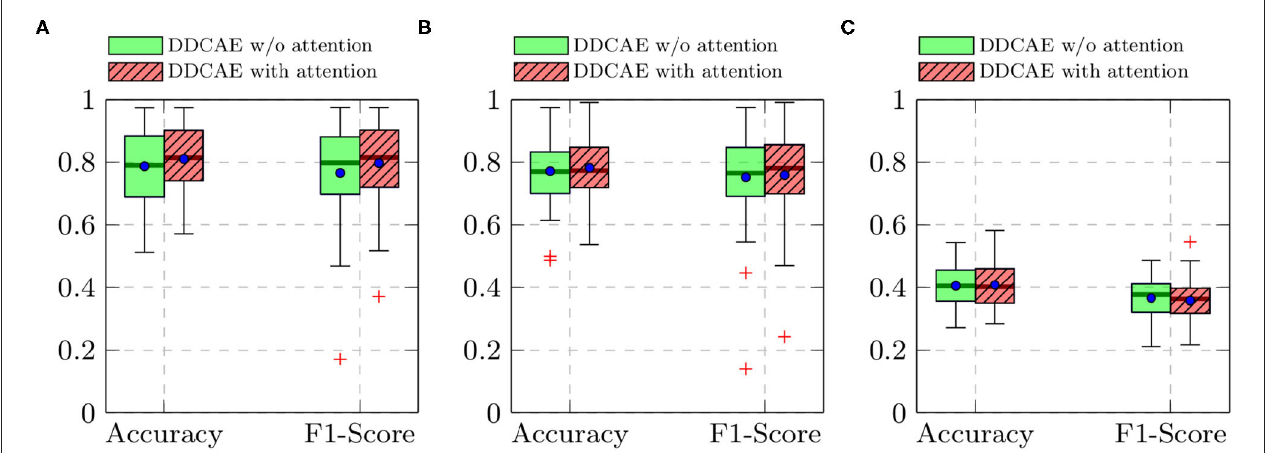
FIGURE 8 | SenseEmotion Database: classification performance comparison in a Leave One Subject Out (LOSO) cross-validation evaluation setting. Within each box plot, the mean and the median classification performance are depicted, respectively with a dot and a horizontal line. (A) T 0 vs . T 3 , (B) T 1 vs . T 3 , (C) 4 classes.